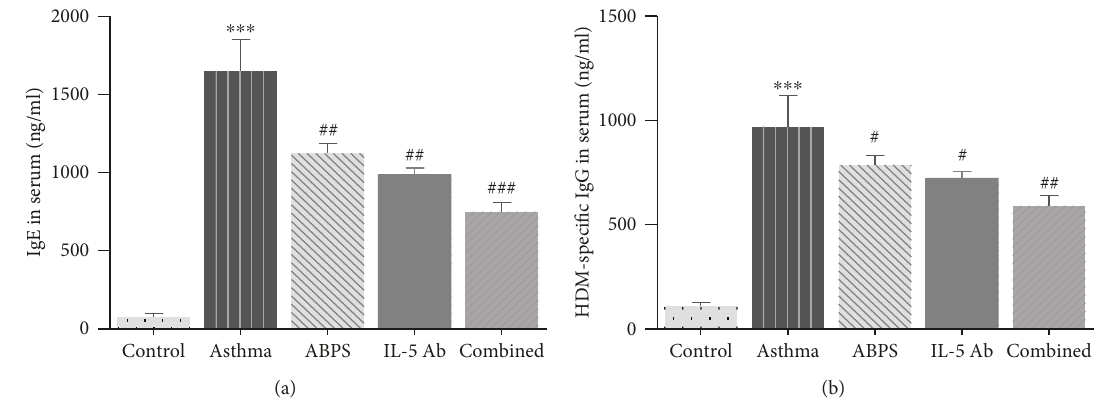
Figure 5: E ff ect of anti-IL-5 mAb and ABPS, respectively, or combined treatment on the levels of IgE and HDM-speci fi c IgG1. Levels of HDM-speci fi c IgG1 (a) and IgE (b) in serum were measured by ELISA data presented as mean ± SEM and are from one experiment, with n = 10 mice per group. ∗∗∗ P < 0 001 , compared to the control group. # P < 0 05 , ## P < 0 01 , ### P < 0 001 , compared to the asthma group. The signi fi cance of the data was evaluated by one-way ANOVA with Bonferroni ’ s multiple comparison test compared to